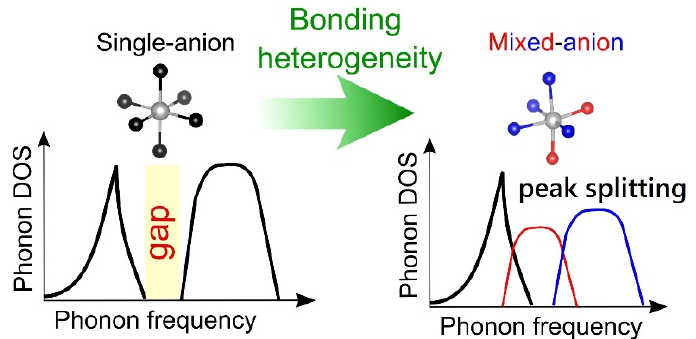
Figure 5. Schematic of the change in the phonon DOS via mixed anion bond heterogeneity [67].